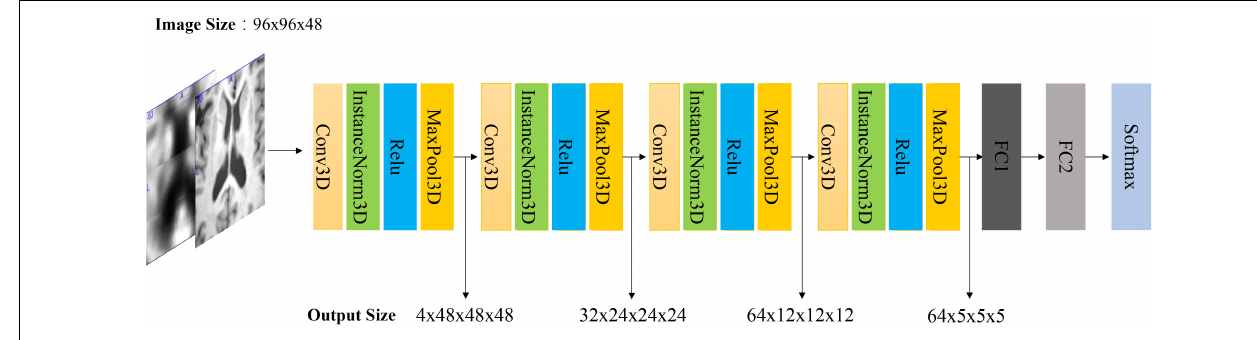
FIGURE 6 | Architecture of our 3D CNN model. Note that if the input is MRI and PET, the input size is 2 × 96 × 96 × 48. The first dimension is the number of channels. FC is a full connected layer. The parameters of FC1 and FC2 are 512 and 2,